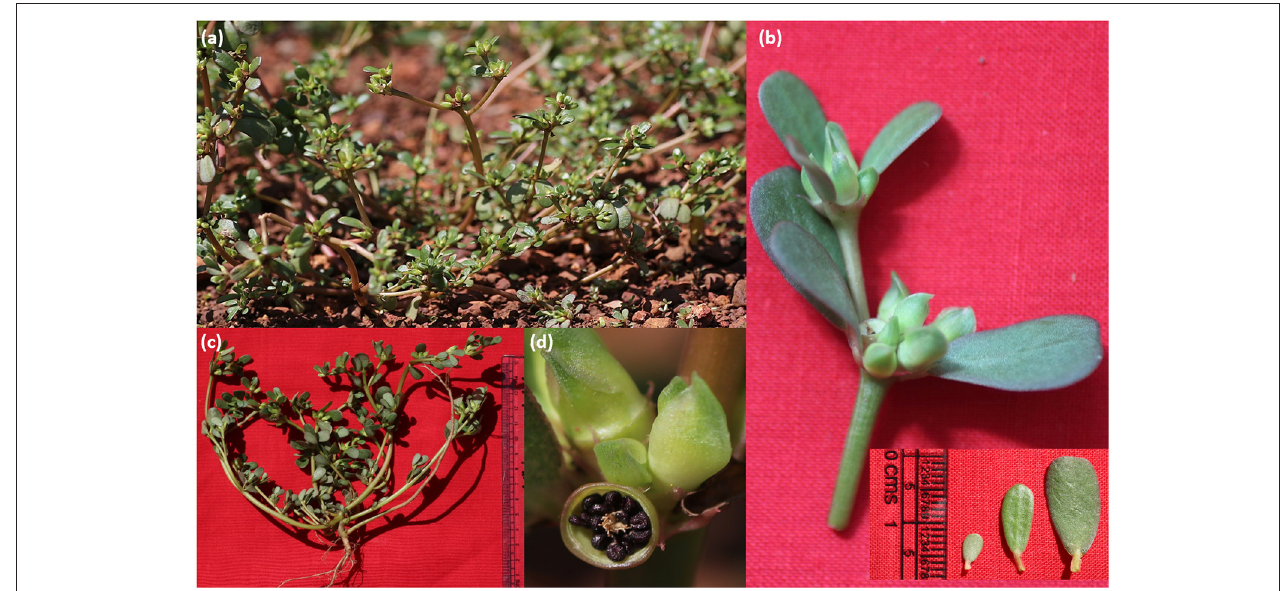
FIGURE 1 | Natural habitat and parts of purslane plant. (a) Purslane plant in natural habitat; (b) young stem with leaves; (c) harvested plant showing roots; and (d) young fruits, known as pyxidia with black-colored